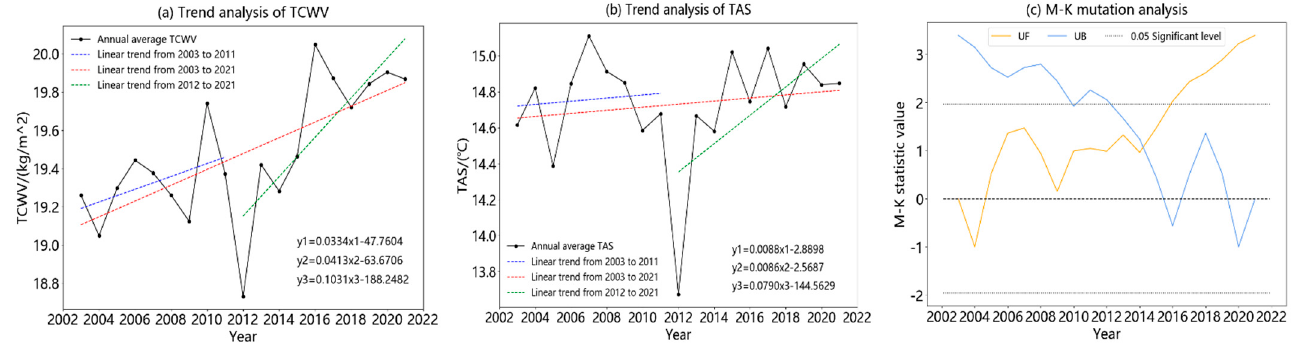
Figure 4. Interannual variation trend. ( a ) Trend analysis of TCWC. ( b ) Trend analysis of TAS. ( c ) M-K mutation analysis.